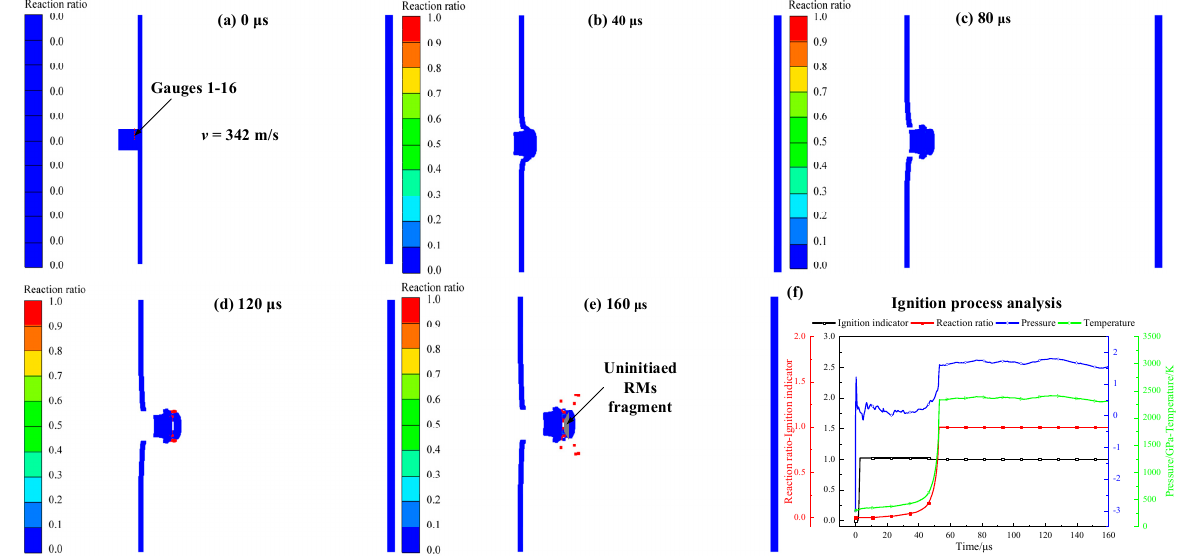
Figure 8. The ignition process of RMPs with a velocity of 342 m/s.